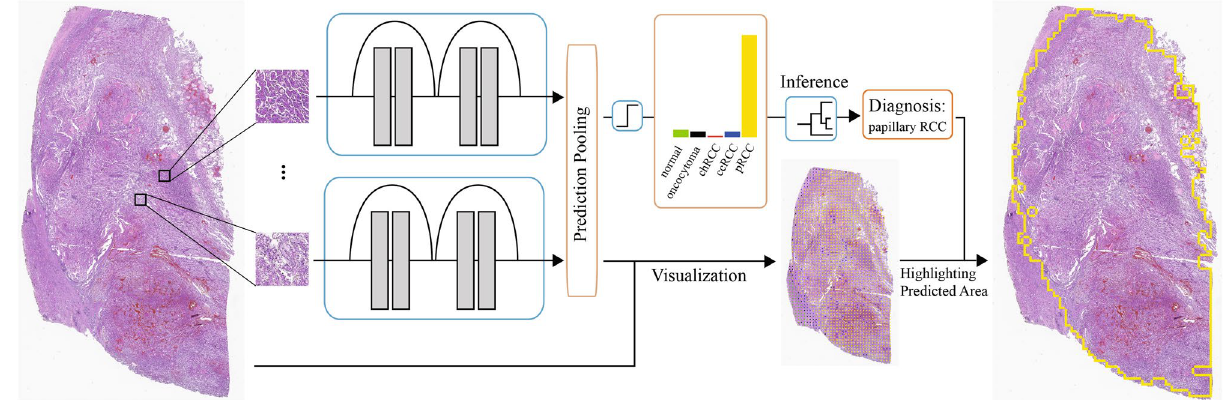
Figure 4. Overview of our classification pipeline. Tissue patches are extracted from whole-slide images using a sliding-window method with 1/3 overlap after background removal. Deep neural networks extract histology features of the patches and compute patch-level confidence scores for each of the target classes. The patch- level predictions are filtered by low-confidence thresholding and aggregated by computing the percentage of patches that belong to each class in a whole-slide image. We classify a whole slide using a decision tree based on the computed percentages of each class. Patch predictions are also used for visualization, which illustrates the coverage of each class on